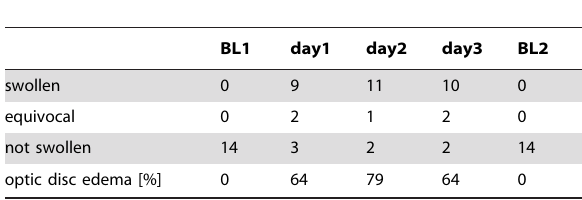
Table 2. Overview of clinical funduscopic